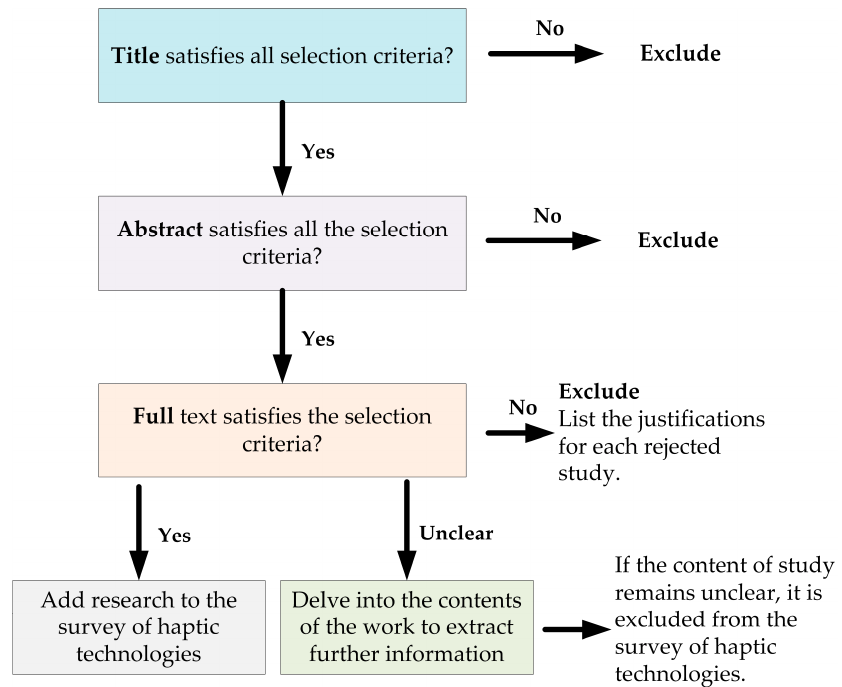
Figure 1. Workflow used for the selection of papers included in the survey of haptic technologies. Overall, the survey of haptic technologies led to the analysis of 138 documents, dis- tributed as reported in Figure 2, where they are classified according to their typology (research articles, review papers, books, and